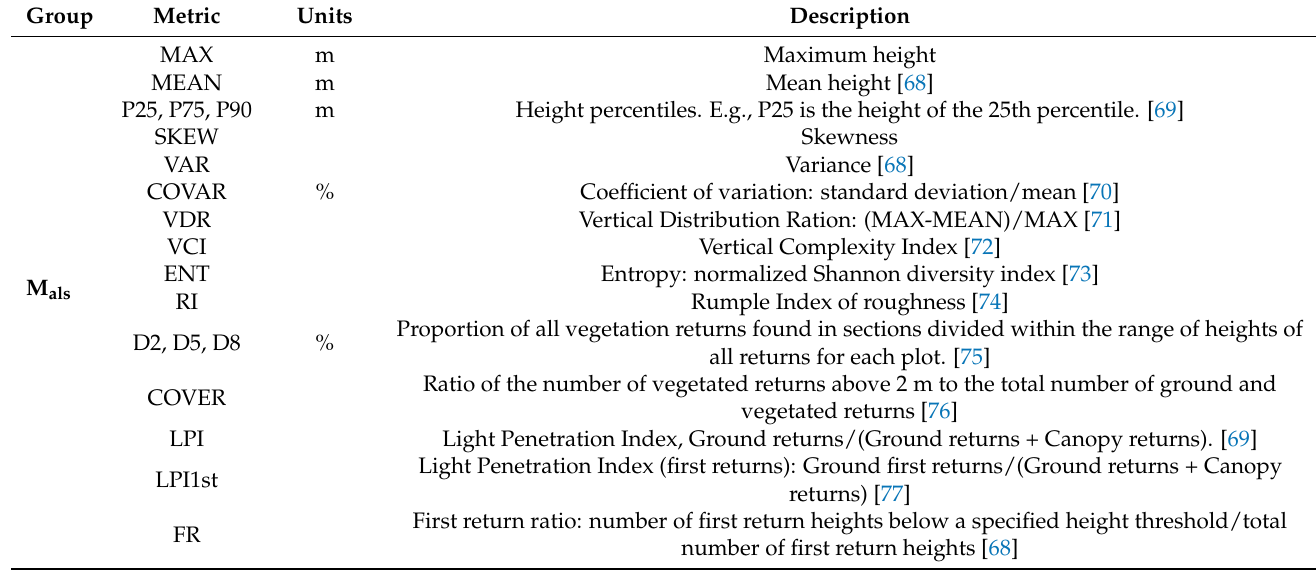
Table 1. Description of metrics and associated groupings used as predictor variables: ALS metrics